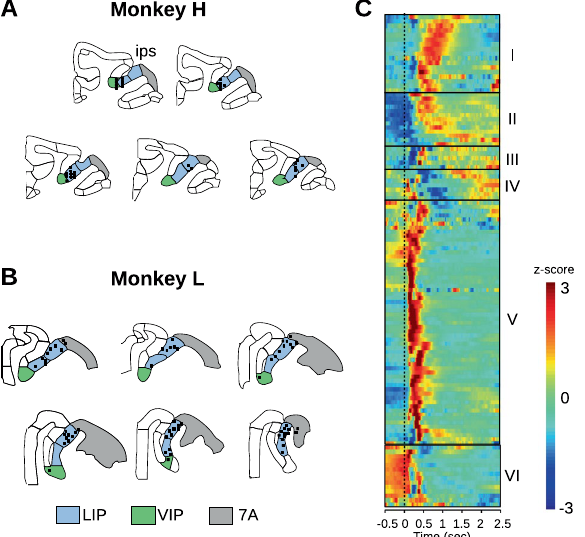
Figure 8. Reconstruction of recording sites and classification of neurons. ( A,B ) Anatomical reconstructions of recording sites ( n = 91) were based on sterotaxic MR images, chamber implantation and angles, and matched to the rhesus macaque anatomical templates 69 . The templates were adapted to overlap over the MRI images plus the recording sites, which ranged from 6 mm posterior to 6 mm anterior to the interaural plane. Blue regions are area LIP, green is VIP, and gray is area 7a. ( C ) Six families of response types were found based on hierarchical clustering of mean firing rate vs. time, across all conditions. The neurons were optimally ordered using correlation